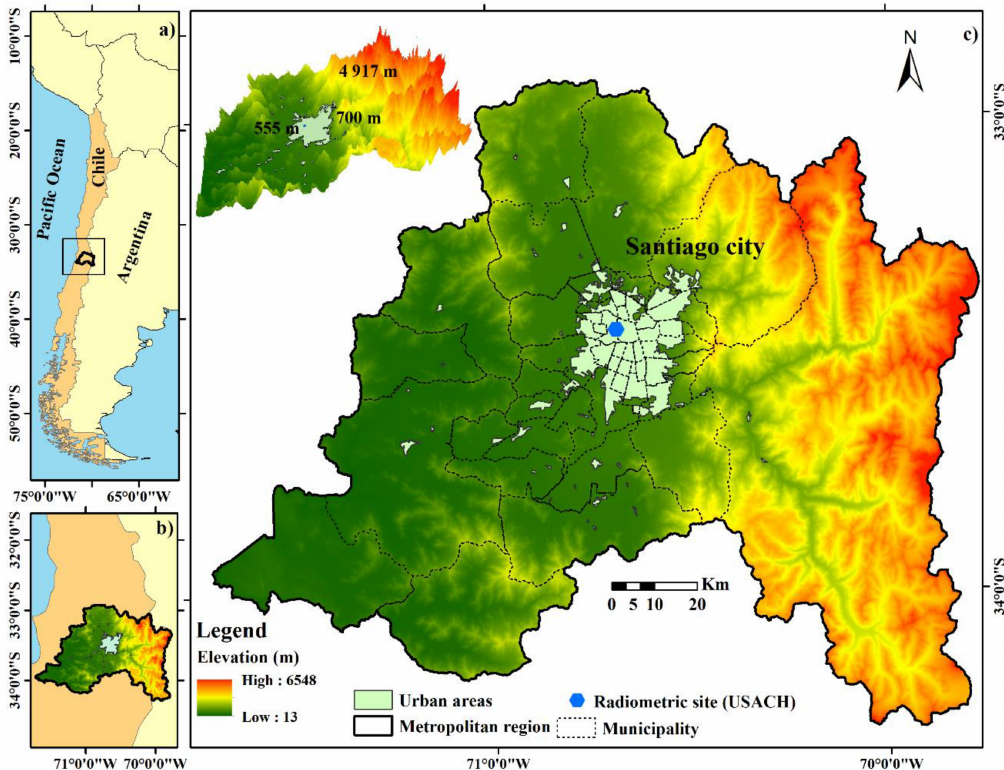
Figure 1. Geographic position of Chile in South-American ( a ) and topography of the city of Santiago de Chile ( b ). The elevation and distribution of municipalities in ( b , c ) were created using an ArcGIS analysis of a shapefile. The shapefiles of the metropolitan region and profile elevation were obtained from IDE